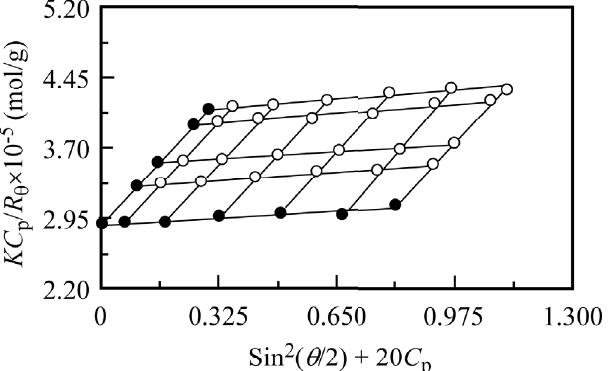
Figure 3. Typical example of a Zimm plot for PMPC The polymer concentration was varied from 5 to 10 g/L. The Rayleigh ratio ( R determined by subtracting the solvent scattering from the total scattering for the